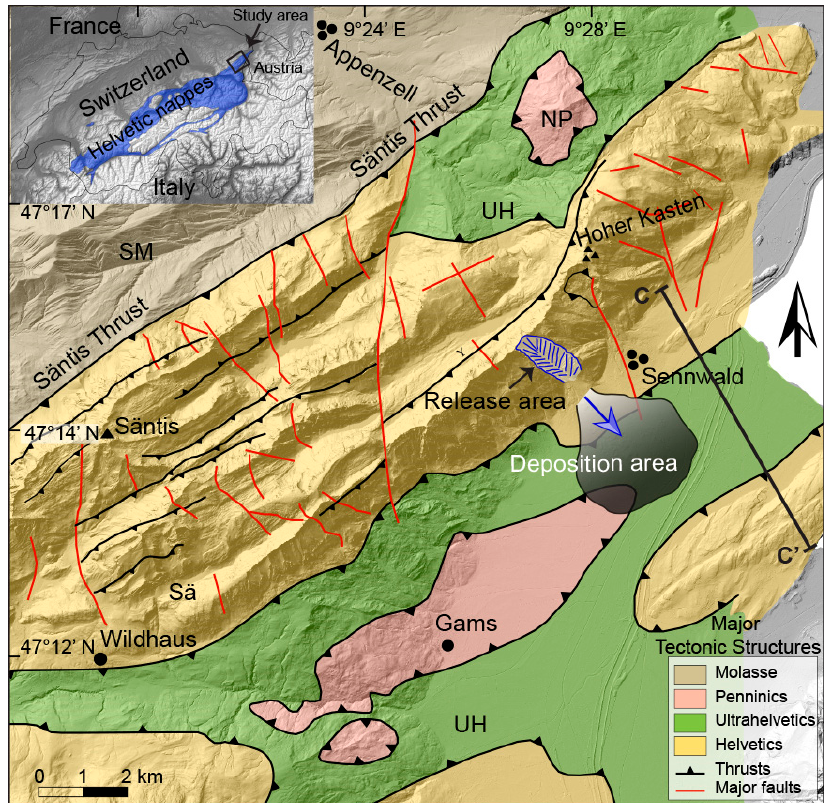
Figure 1. Tectonic map of the Säntis nappe including major tectonic structures and the landslide release and deposition area. Location bar is shown in the top left corner with the Helvetic nappes indicated with blue. Shaded relief image superimposed by a color-coded DEM (swissALTI3D) reproduced with the authorisation of swisstopo (JA100120). The tectonic map is modified following [28].